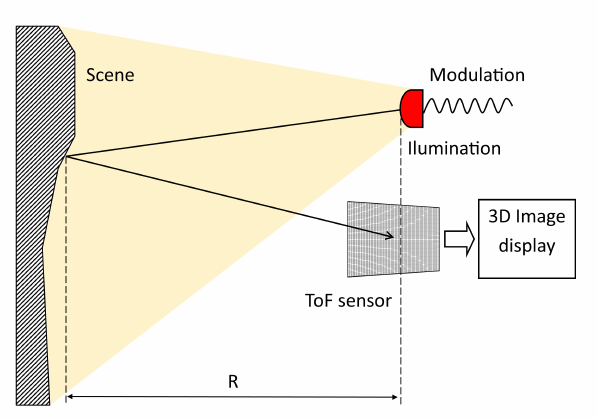
Figure 1. Time of Flight (ToF) camera phase-measurement principle [13].